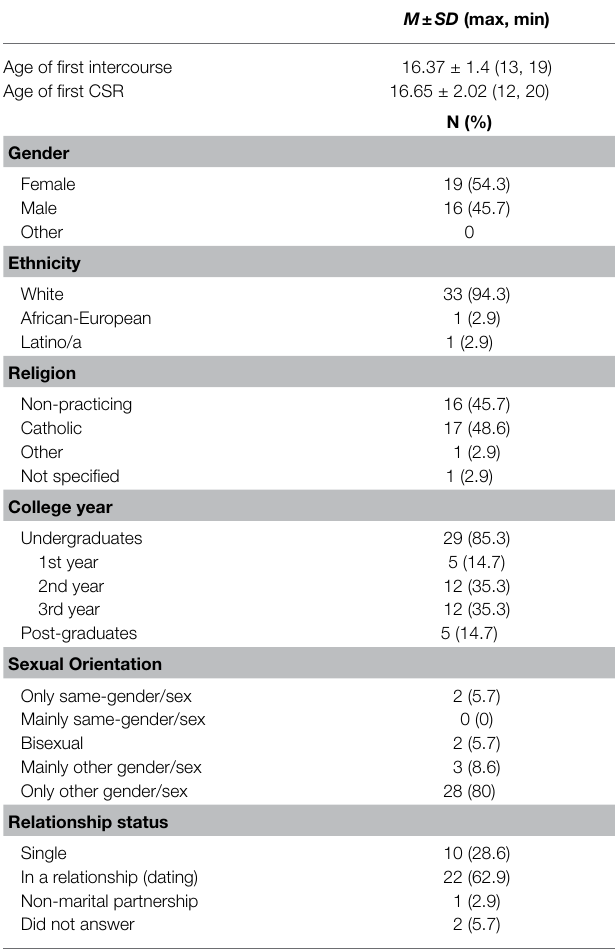
TABLE 1 | Demographic characteristics of the sample ( N =